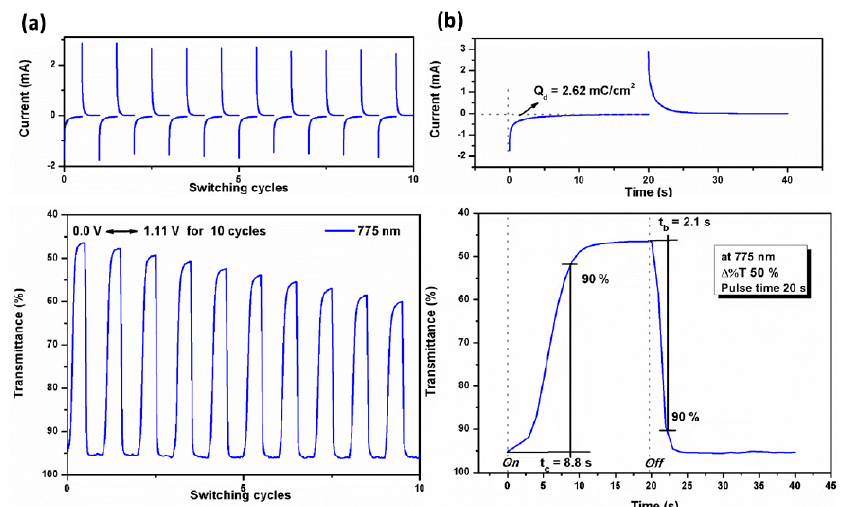
Figure 19. Potential step absorptiometry of the cast film of TPA–TPPI on the ITO-glass slide (coated area ~1 cm 2 ) (in CH 2 Cl 2 with 0.1 M Bu 4 NClO 4 as the supporting electrolyte) by appling a potential step; ( a ) optical switching at potential 0.00 V ⬄ 1.11 V (10 cycles) with a pulse width of 20 s, monitored at λ max = 775 nm; ( b ) the 1st cycle transmitance change for the TPA–TPPI thin film.